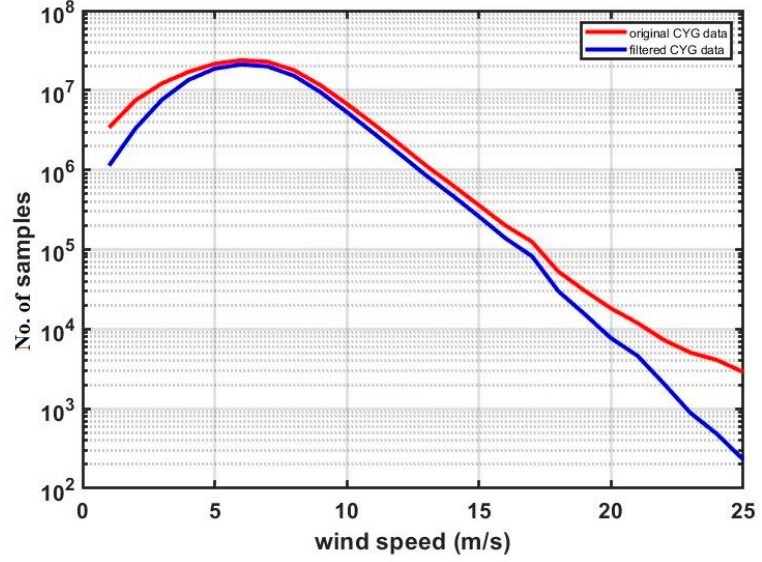
Figure 10. Distribution of CYGNSS retrieved winds before and after QC filter.